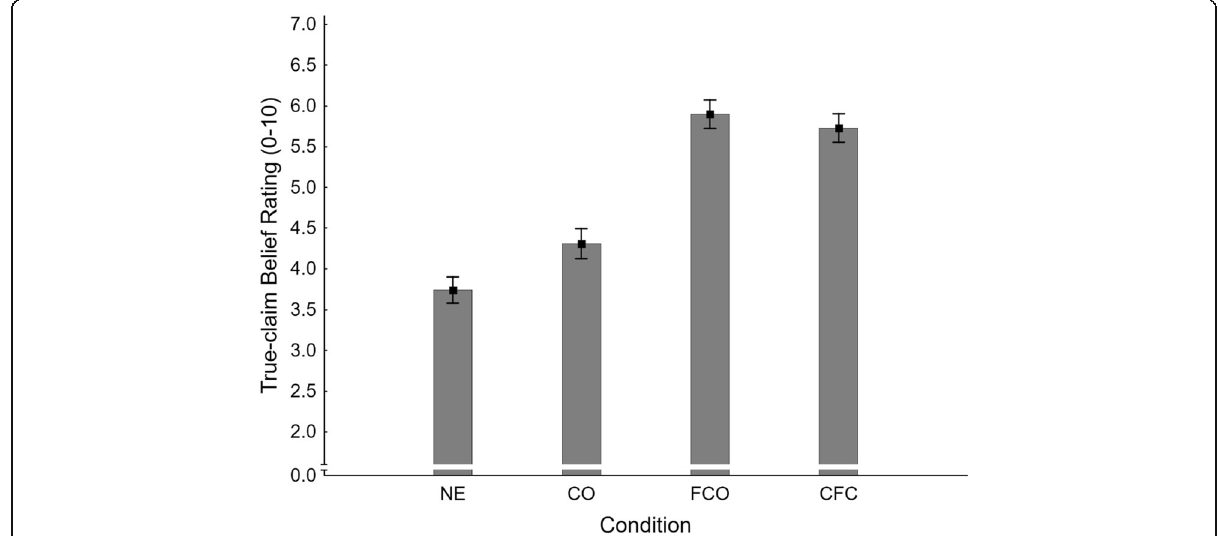
Fig. 6 Mean true-claim belief ratings across conditions NE (no-exposure), CO (claim-only), FCO (fact-check-only), and CFC (claim-plus-fact-check) in Experiment 1. Error bars show standard errors of the mean